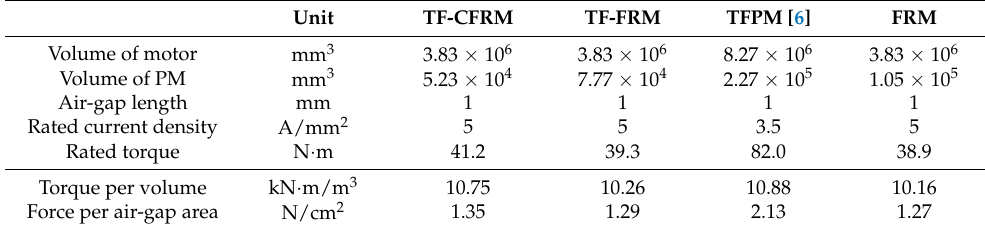
Table 2. Torque density comparison of TF-CFRM, TF-FRM, TFPM, and FRM.